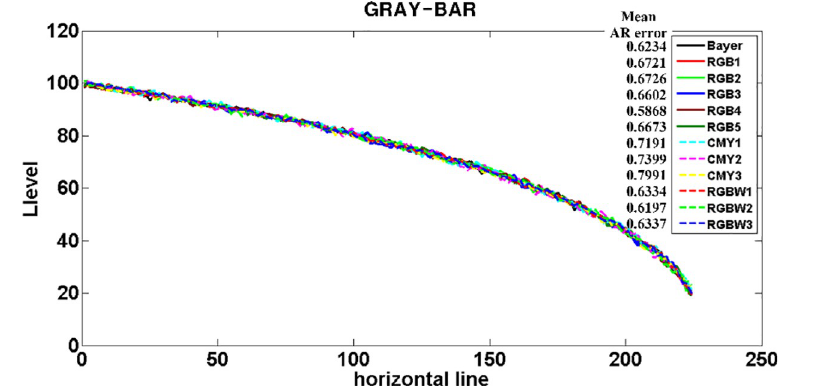
Fig 14. Luminance value curve and mean AR error value for test CFAs.